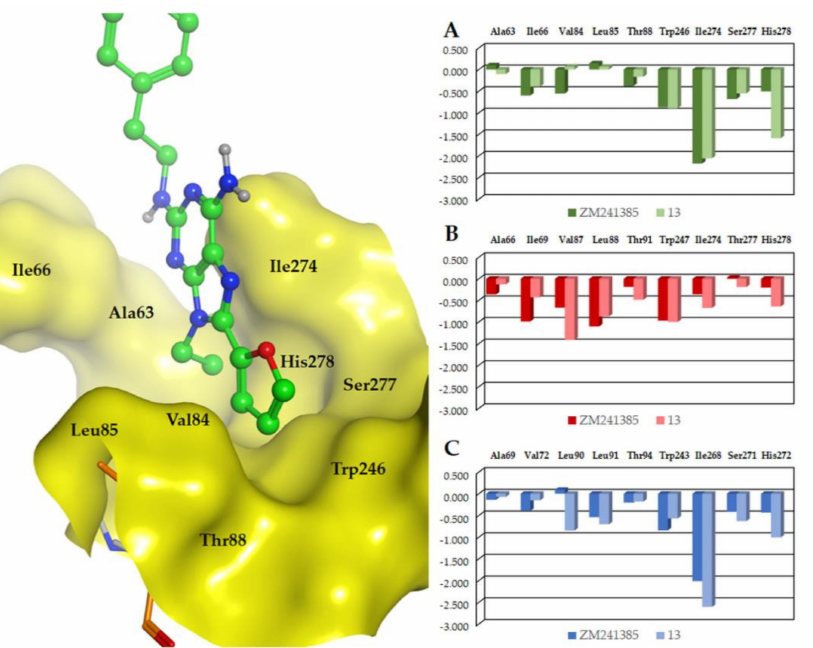
Figure 8. Interaction energies (represented as kcal mol − 1 ) calculated with the aid of the IF-E 6.0 tool at the A 2A AR ( A ), A 1 AR ( B ), and A 3 AR ( C ) binding sites. Compounds ZM241385 and 13 were submitted to analysis. Receptor residues in proximity to the compound region corresponding to the 9-ethyl substituent of 13 were considered. In the panel at left, there is a representation of the analyzed residues and their position with respect to the 9-ethyl group (surface representation); the labels indicate the A 2A AR residues. See text for